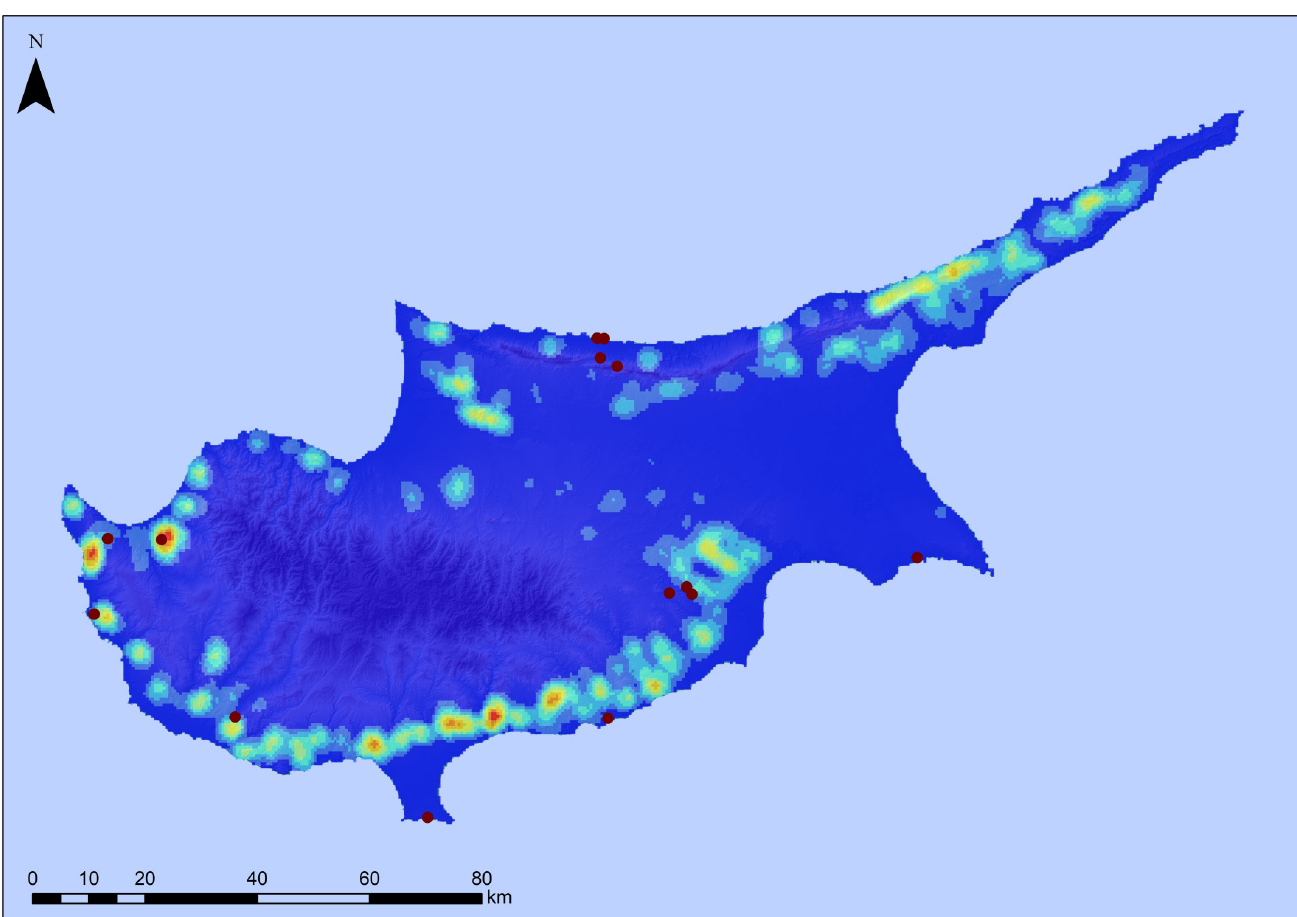
Fig 5. Probability map based on one-class classification analysis. Probability map based on one-class classification analysis, using the Spectral Angle Mapper (SAM) classifier. The map illustrates areas where there is a higher probability to share similar attributes with the ones of the fifteen earliest known archaeological sites of Cyprus. The dark red dots represent known early archaeological sites on Cyprus (see Fig 1 for site names). Original copyright with the authors.